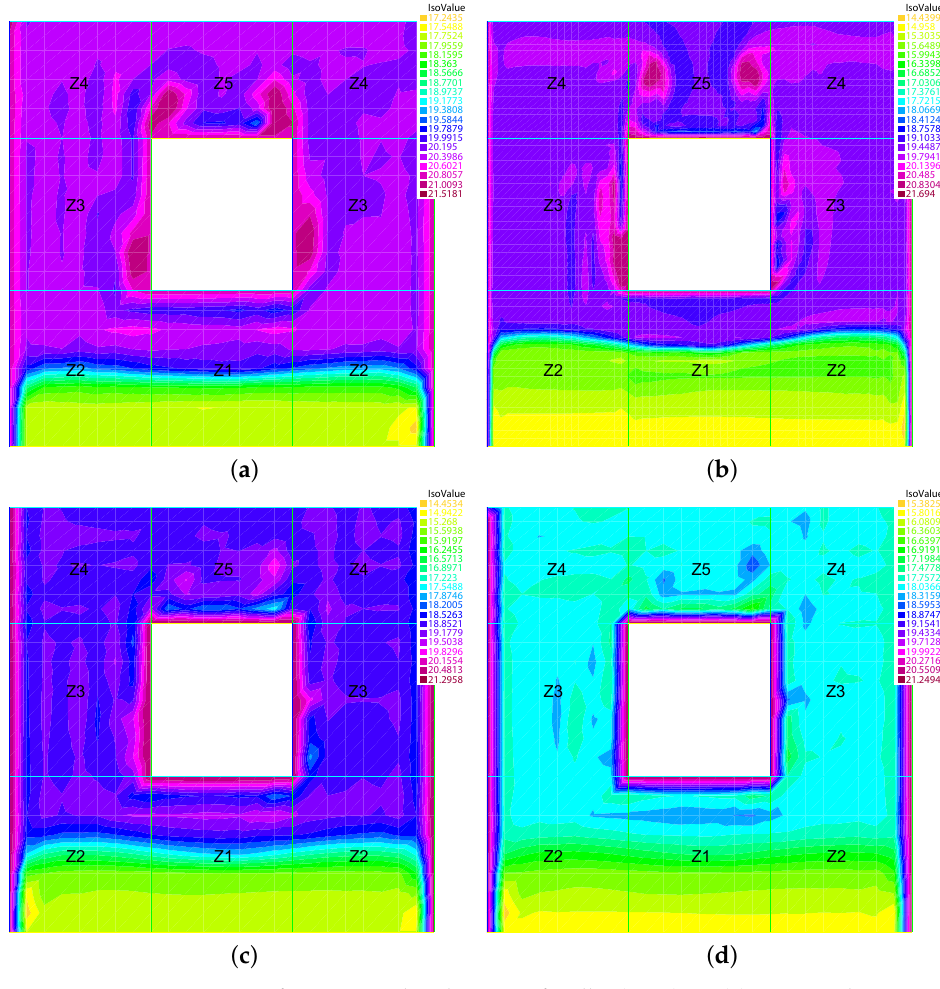
Figure 18. Temperatures of air in ventilated cavity of Cell 1 (OVF) in: ( a ) cutting plane at 0.02 m; ( b ) cutting plane at 0.04 m; ( c ) cutting plane at 0.06 m; ( d ) cutting plane at 0.08 m from the outer slab. From this velocity and temperature behavior the three-dimensional nature of the air flow thermodynamic in the air cavity can be clearly